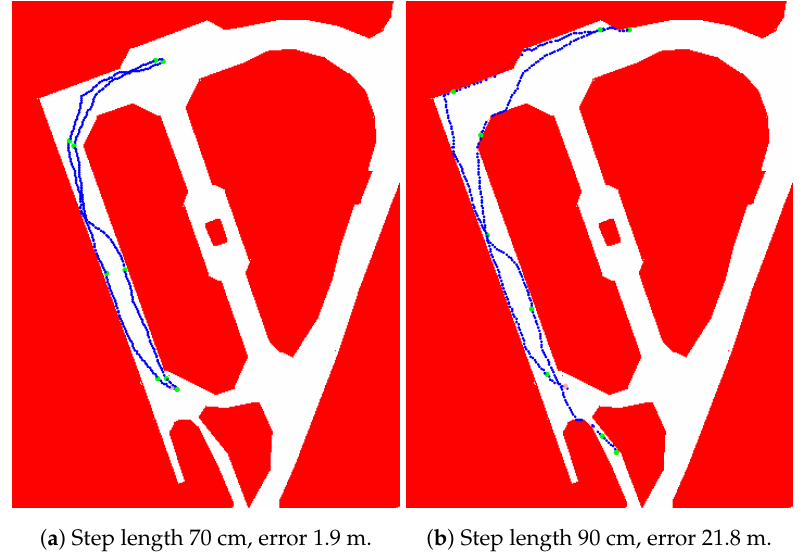
Figure 9. Two trajectories for the T04 logfile. The path in the shopping mall consists of the walking along the corridor, passing to the next corridor to the right, the 180 ◦ turnover, and the walking back to the initial position. Both outputs are based on the fine mask grid filter using the step SD 5 cm and the turn SD 25